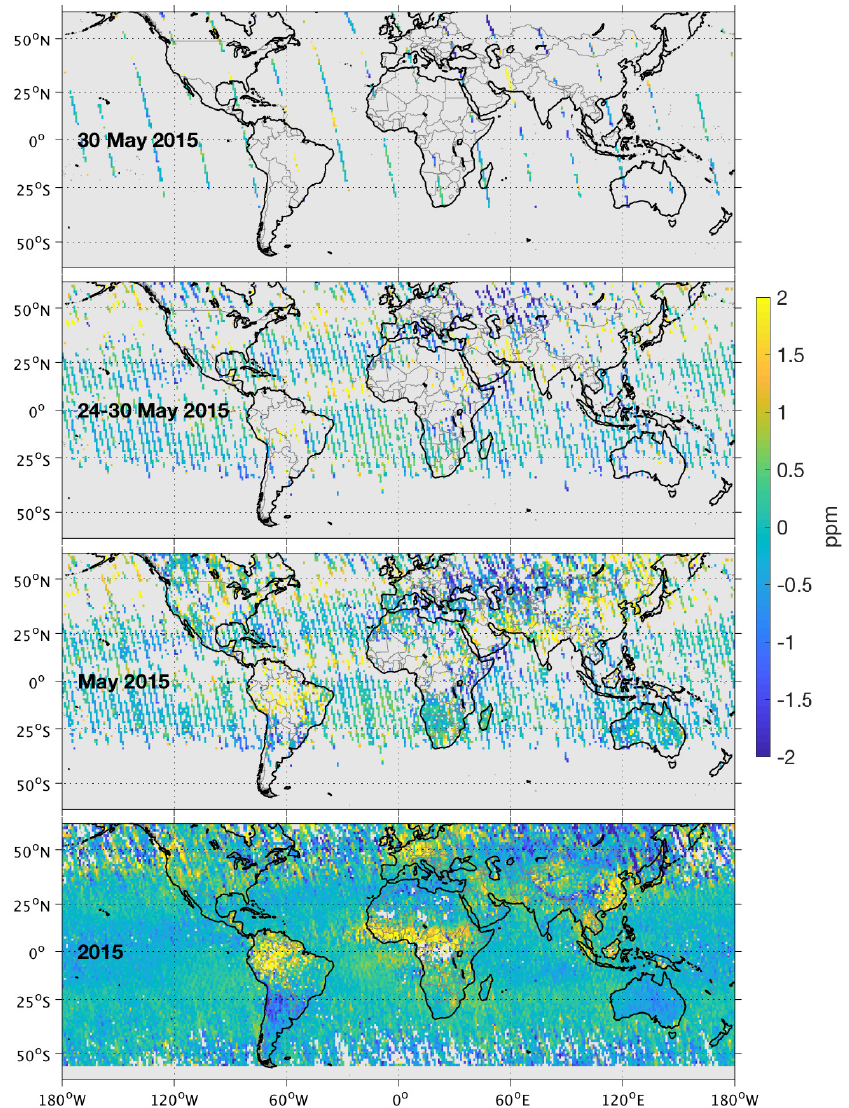
Figure 1. Mean Orbiting Carbon Observatory-2 (OCO-2) XCO 2 anomalies on 1 ◦ × 1 ◦ latitude-longitude grid during one day, one week, one month and one year. For the background we calculate the daily medians for each 10-degree latitude bands and linearly interpolate the resulting values to each OCO-2 data